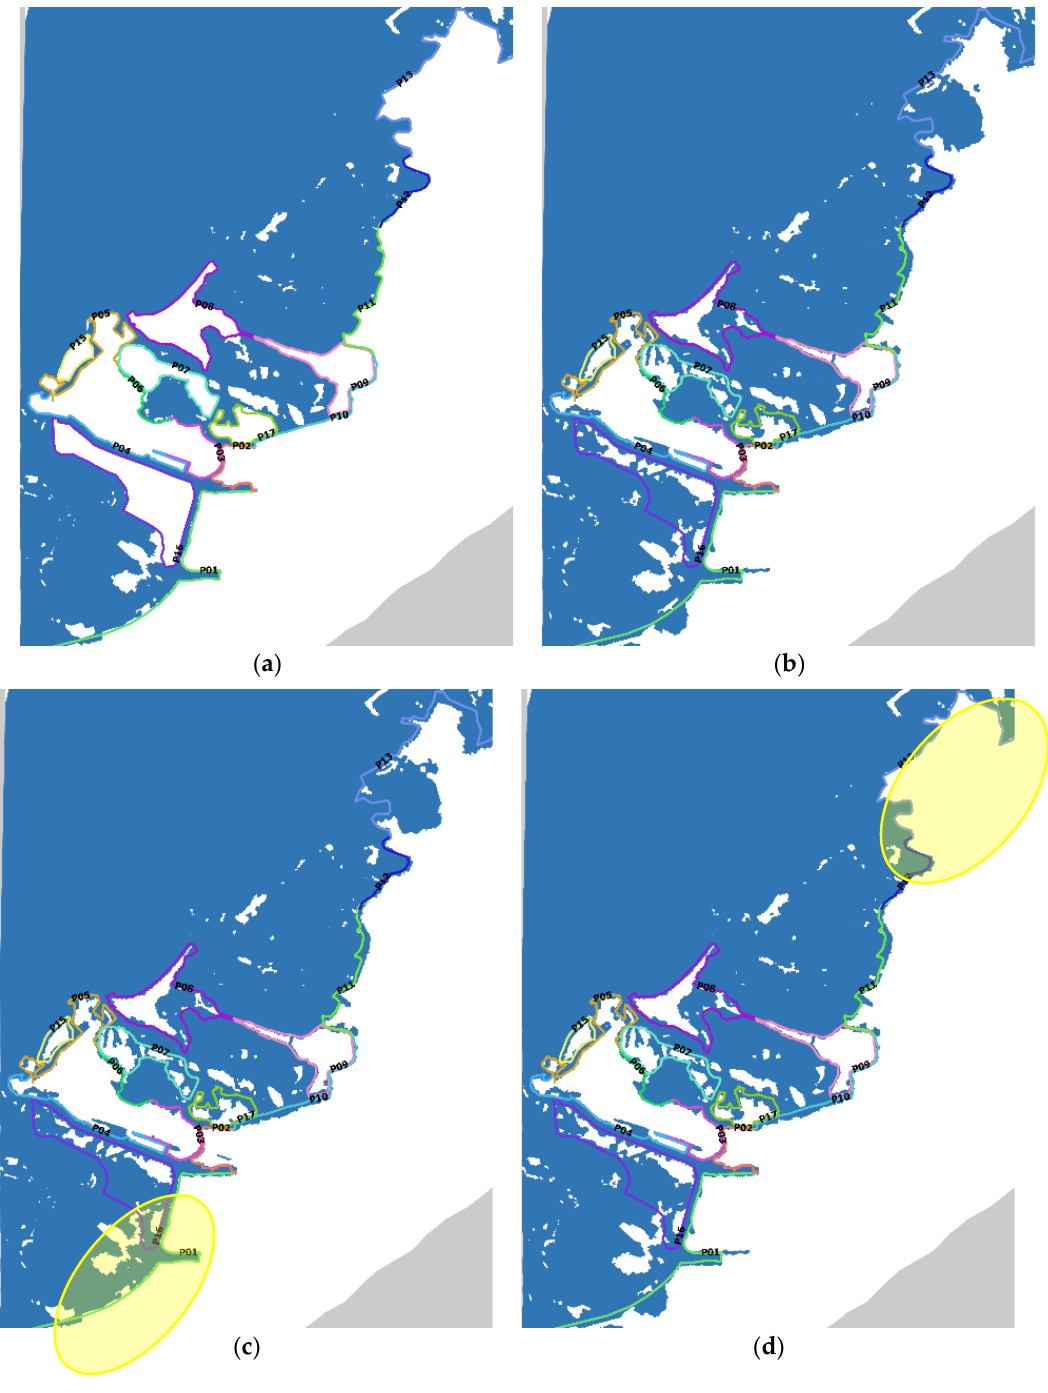
Figure 8. Examples of flooding extent predicted by model with various coastal protection scenarios shown as pink outlines: ( a ) all precincts from Figure 7 protected; ( b ) no precincts protected; ( c ) Precinct 1 protected (Mussafah); ( d ) Precinct 13 (Khalifa Port) protected. Colored outlines show the coastal outlines of each precinct. The highlighted areas in ( c , d ) represent the protected precincts and the changes of the inundation are observable.